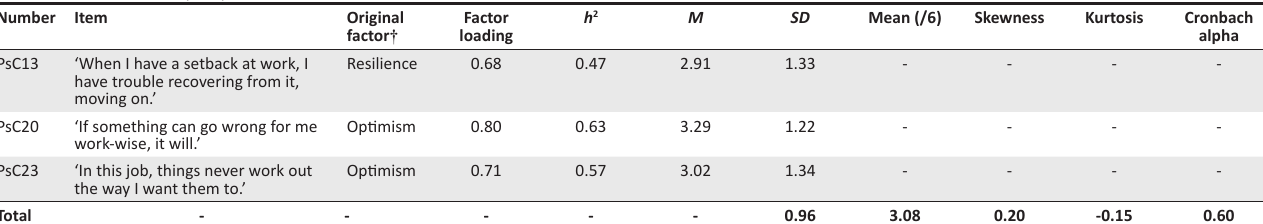
TABLE 11: Factor 4 – Buoyancy. Number Item